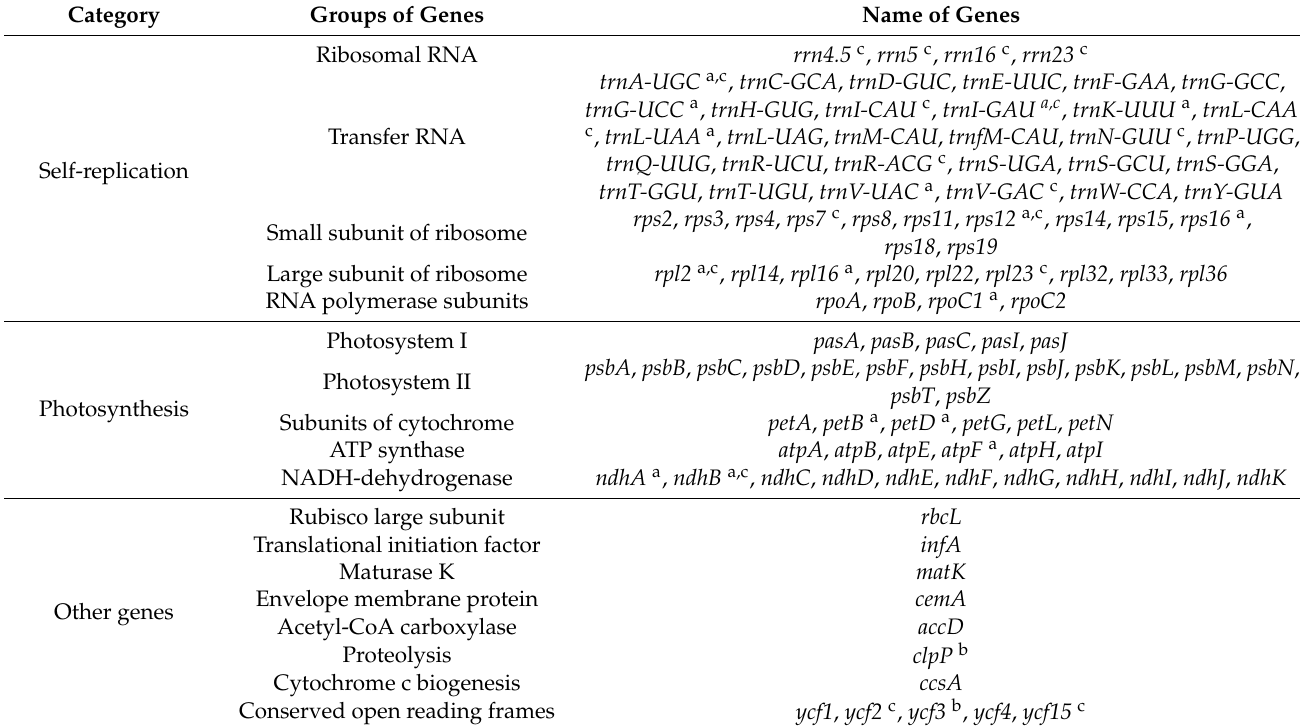
Table 2. List of the annotated genes in the chloroplast genomes of C. fargesii